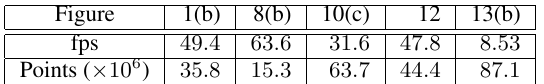
Table 1. Rendering speeds (fps) and numbers of points for point clouds with 3D edges